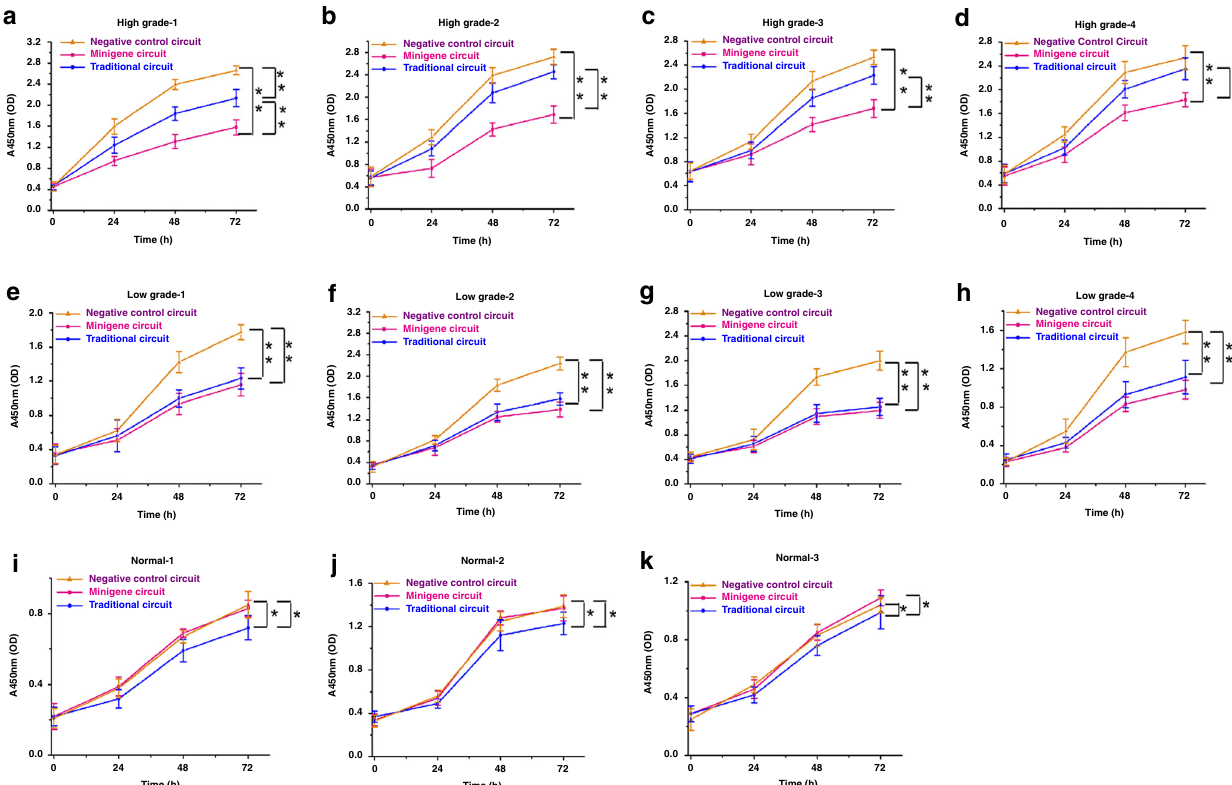
Fig. 3 Growth curves of bladder cell lines transfected with either the minigene circuit or the traditional circuit. Proliferations of the transfected cells “ high grade-1 ” ( a ), “ high grade-2 ” ( b ), “ high grade-3 ” ( c ), “ high grade-4 ” ( d ), “ low grade-1 ” ( e ), “ low grade-2 ” ( f ), “ low grade-3 ” ( g ), “ low grade-4 ” ( h ), “ normal-1 ” ( i ), “ normal-2 ” ( j ), and “ normal-3 ” ( k ) were measured using the CCK-8 assay at different time intervals. The minigene circuit without output gene was used as the negative control. The curves of cell proliferations were compared using two-way analysis of variance (ANOVA). The results at each time point are shown as the mean ± SD. Each experiment was independently performed in triplicate fi ve times. Each error bar indicates the variation between the means of fi ve independent experiments. * p < 0.05 and ** p < 0.01 between the groups. Exact p -values for asterisks (from left to right):